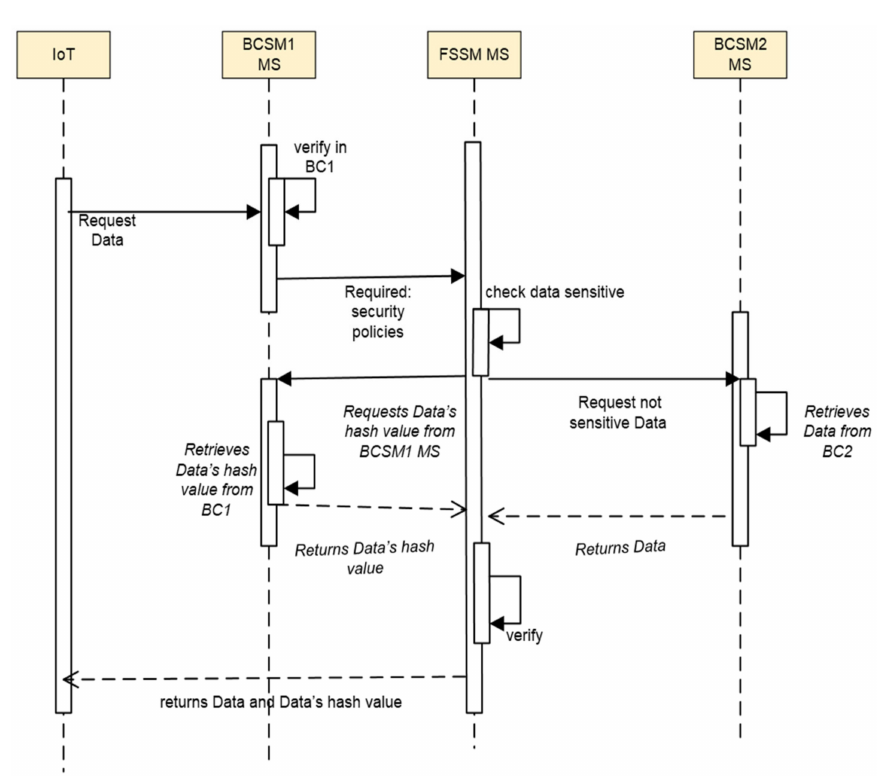
Figure 6. Sequential diagram of FSSM